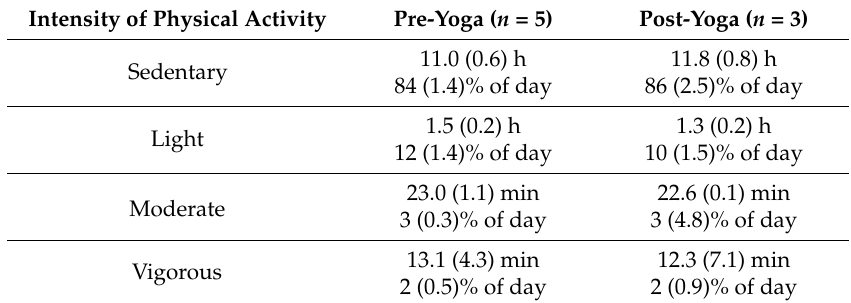
Table 6. Average (standard deviation, SD) amount of time spent in physical activity pre- and